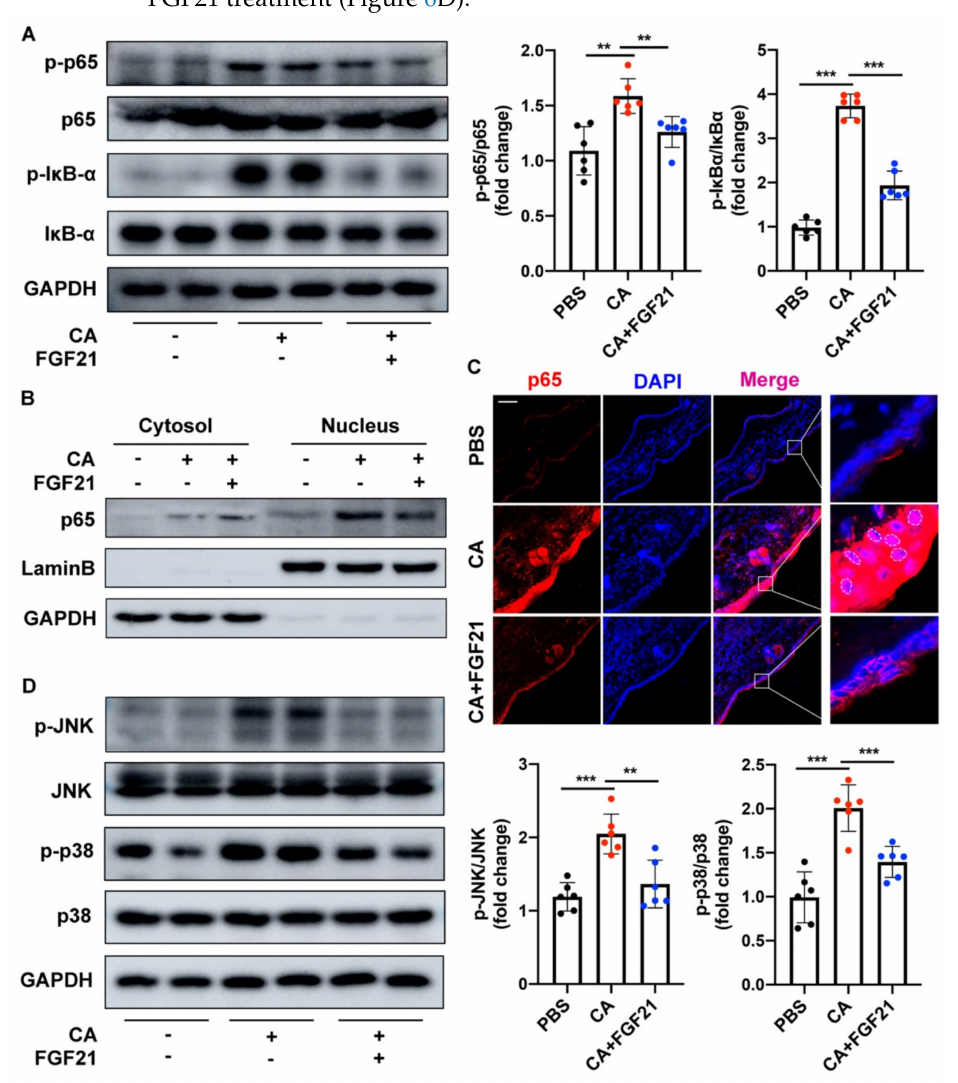
Figure 6. FGF21 suppresses C. acnes -induced inflammation by inhibiting TLR2/NF- κ B/MAPK signaling pathways in mouse ears. ( A ) Protein expression levels of p65 and I κ B in C. acnes -stimulated mouse ears with and without FGF21 treatment ( n = 6 mice/group). ( B ) The nuclear and cytosolic fractions of p65 assayed by Western blotting ( n = 6 mice/group). ( C ) Representative confocal scans are shown for p65 (red), and the nuclei are stained with DAPI (blue) ( n = 6 mice/group). Scale bar = 50 µ m. ( D ) Protein expression levels of JNK and p38 in C. acnes -stimulated mouse ears with and without FGF21 treatment ( n = 6 mice/group). All data are presented as the mean ± the SD; ** p < 0.01, and *** p <